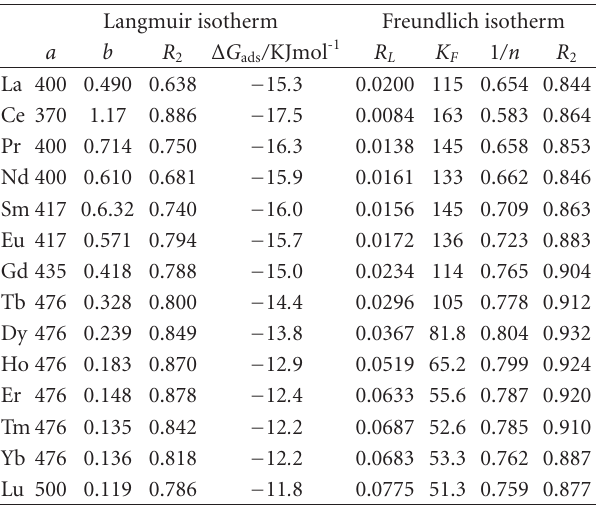
Table 3: Coe ffi cient of Langmuir and Freundlich isotherms for lanthanides using original Buccinum tenuissimum shell biomass. Langmuir isotherm Freundlich